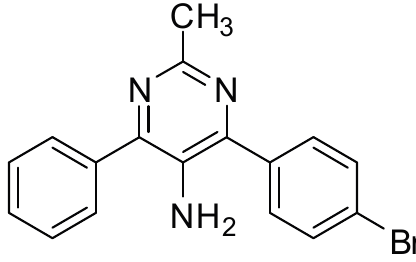
Figure 3. 5-Aminopyrimidine